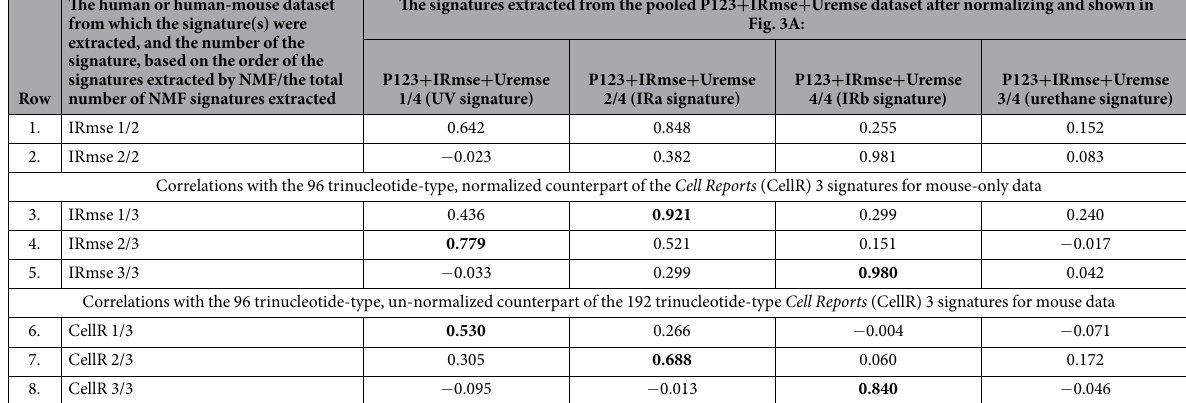
Table 2. Correlations of the four signatures from the P123 + IRmse + Uremse dataset with signatures from only the irradiated mouse samples, IRmse, with and without normalizing frequencies before NMF. Table 2 shows the correlations for (1) four signatures extracted from the pooled P123 + IRmse + Uremse dataset shown in Fig. 3A, with normalized NMF input frequencies, (2) three signatures extracted from the IRmse dataset only, with normalized NMF input frequencies, and (3) three signatures extracted from the IRmse dataset, but with un-normalized frequencies. Of the three NMF-derived signatures for the normalized IRmse data, the first of the three signatures is correlated 0.92 with the IRa signature, and the third of these signatures is correlated 0.98 with the IRb